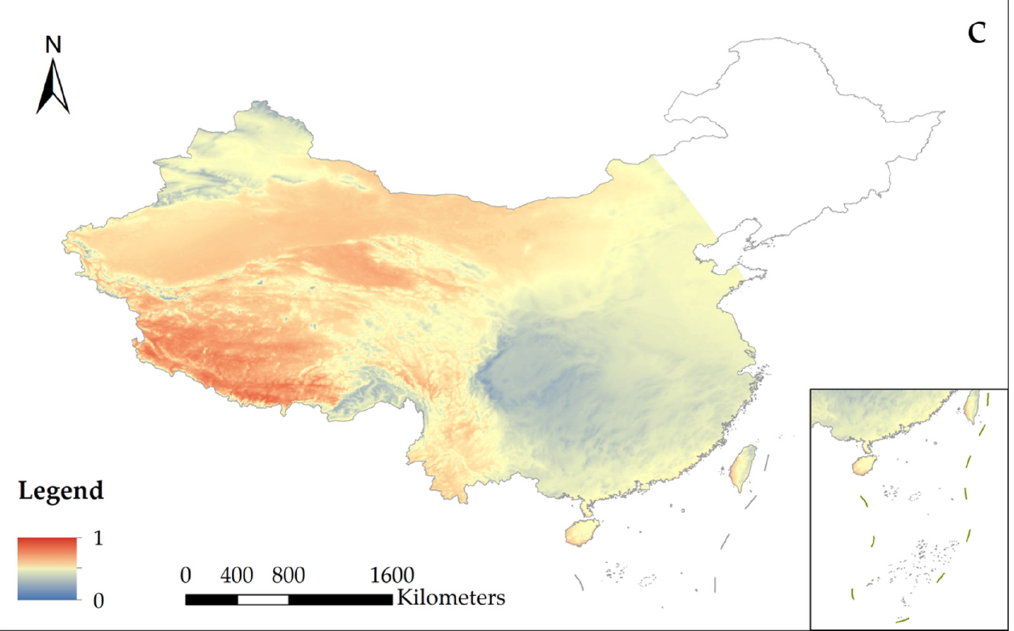
Figure 15. Comparison of the annual distribution of PV energy (after normalization) in China. ( a ) Annual average daily total solar radiation data. ( b ) GHI of the World Bank. ( c ) Yearly average irradiance from PVGIS.